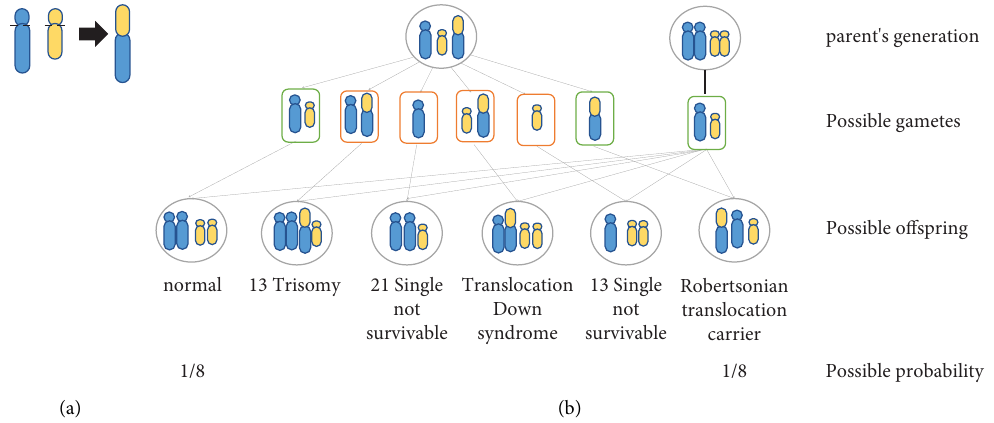
Figure 2: (a) Robertsonian translocations on non-homologous chromosomes. (b) Possible gametes in patients with robertsonian translocations. Non-homozygous robertsonian translocations can produce six types of gametes in the formation of germ cells, one normal, one balanced, and the remaining four unbalanced gametes. Normal and balanced gamets are designated by green border, and unbalanced gametes are designated by red border. Te probability of normal and robertsonian translocation carrier are both